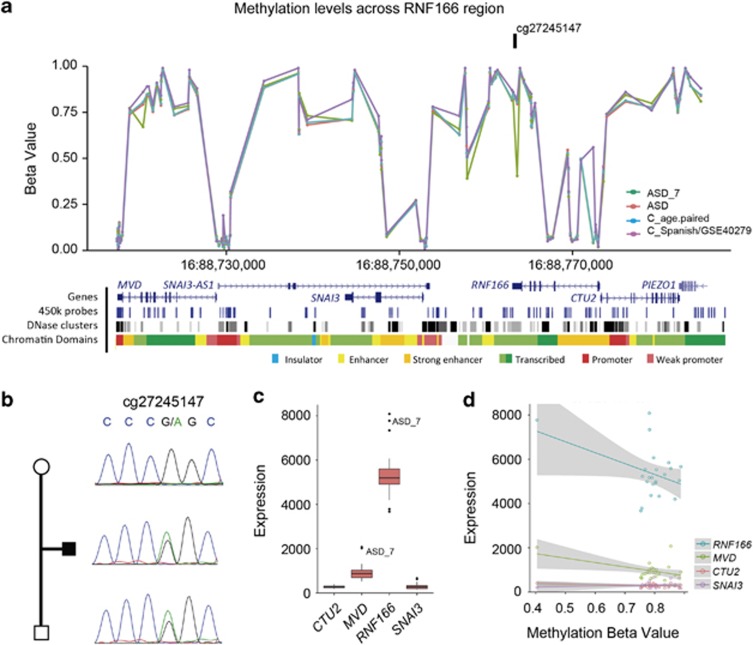
Heterozygous meSNV associated with overexpression of several regional genes at 16q24.3. (a) Beta values across the region for the patient (green), the rest of the patients (red), the age-paired (blue) and the Spanish and GEO (GSE:40279; purple) controls sets. Diagram under the graphs shows the genes in the region, 450k array probes, the DHSs and chromatin domains in the region. (b) Sanger sequence for the DMCpG showed a paternally inherited meSNV (G>A). (c) Expression levels showed overexpression of RNF166 and MVD, and a tendency in CTU2 (d) correlation for methylation values and expression for the genes for all ASD samples. ASD, autism spectrum disorder; C, controls; DHSs, DNAseI hypersensitive sites.